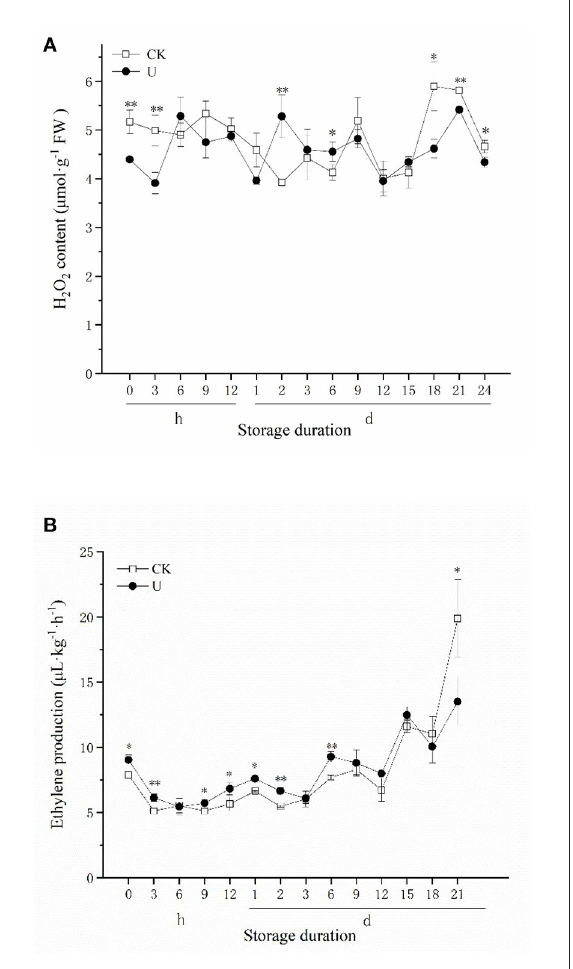
FIGURE4 Effect of ultrasound on H 2 O 2 content (A) , ethylene production (B) in strawberries during storage. Data represent the means ± SE, n = 3. According to independent t -tests, asterisks indicate significant difference (* P < 0.05, ** P < 0.01) between CK and U treatments at the same time